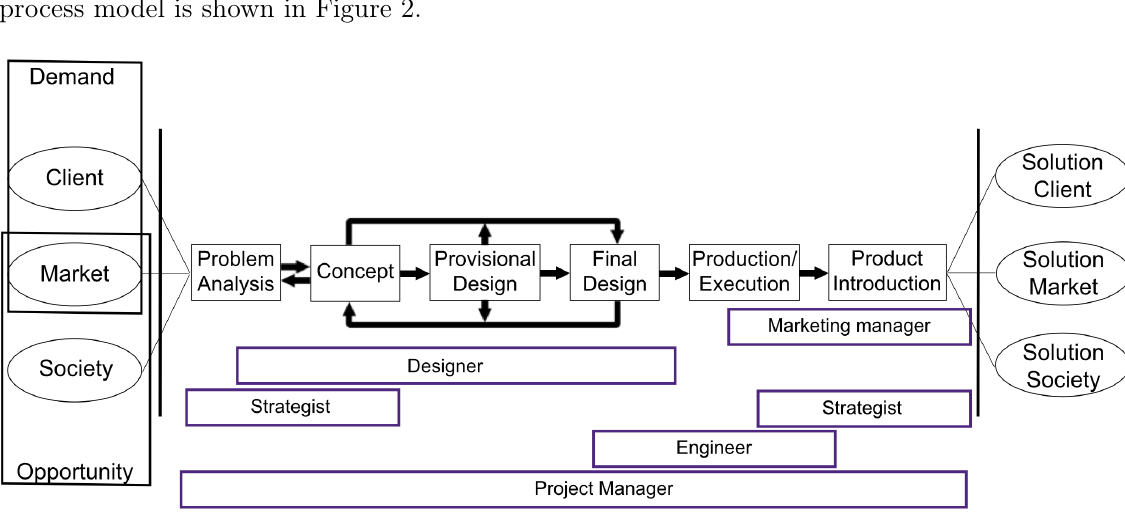
Fig. 2. Process-model supplemented with job function